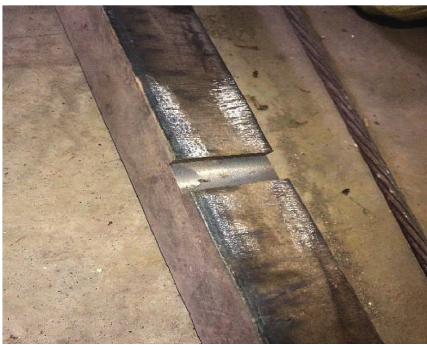
Figure 29: Damage setting. Table 3: Details of experiment scenarios.